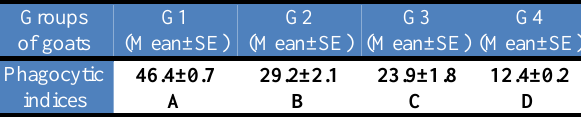
Table, 3: The phagocytic indices in immunized, infected and control groups (Mean ±